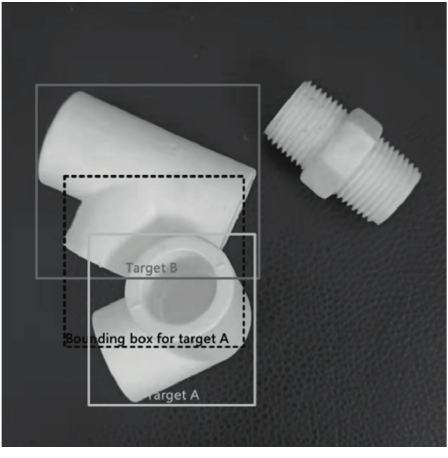
Figure 6: Schematic diagram of exclusion